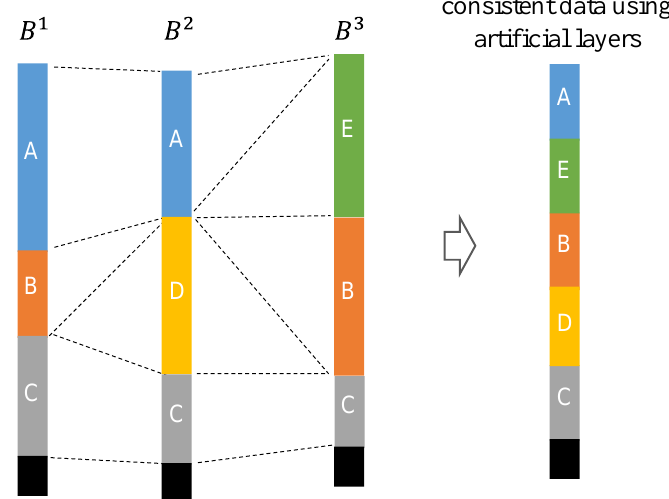
Figure 1. Constructing a ground model using artificial layers.